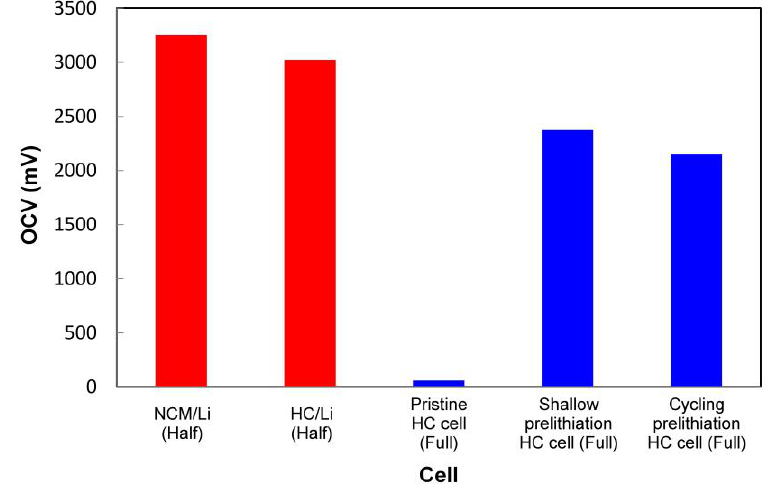
Figure 4. The open circuit voltage (OCV) of the half-cells and full-cells just after cell assembly.